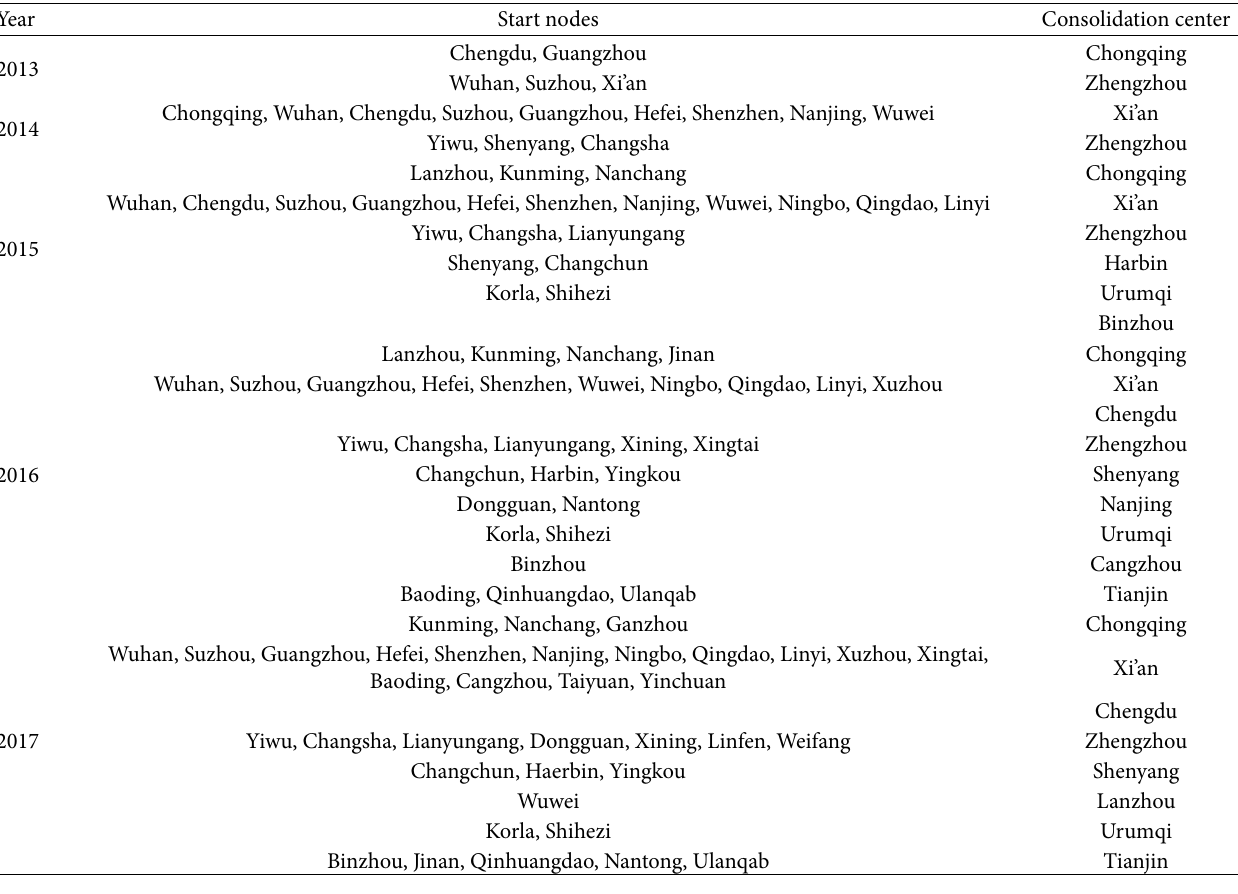
Table 4: Selection of consolidation routes and the corresponding consolidation